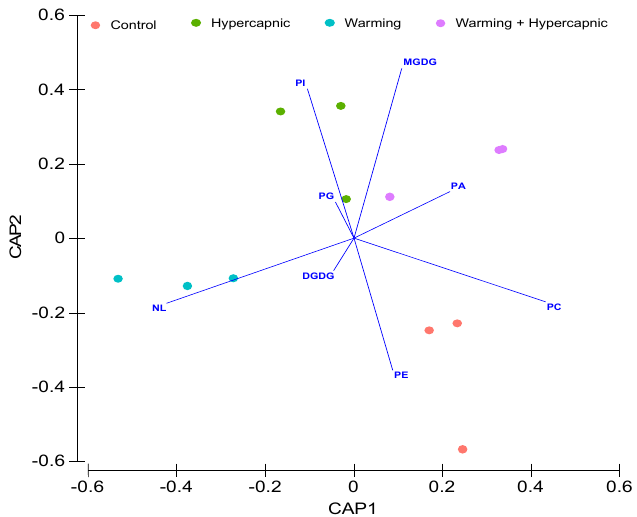
Figure 4. Relative Zostera noltii leaf lipid concentration canonical analysis of principal (CAP) components of the samples exposed to control, hypercapnic, warming and combined stress conditions ( n = 3 per treatment; monogalactosyldiacylglycerol, MGDG; digalactosyldiacylglycerol, DGDG; phosphatidylcholine, PC; phosphatidylethanolamine, PE; phosphatidylglycerol, PG; phosphatidylinositol, PI; phosphatidic acid, PA; neutral lipids, NLs).